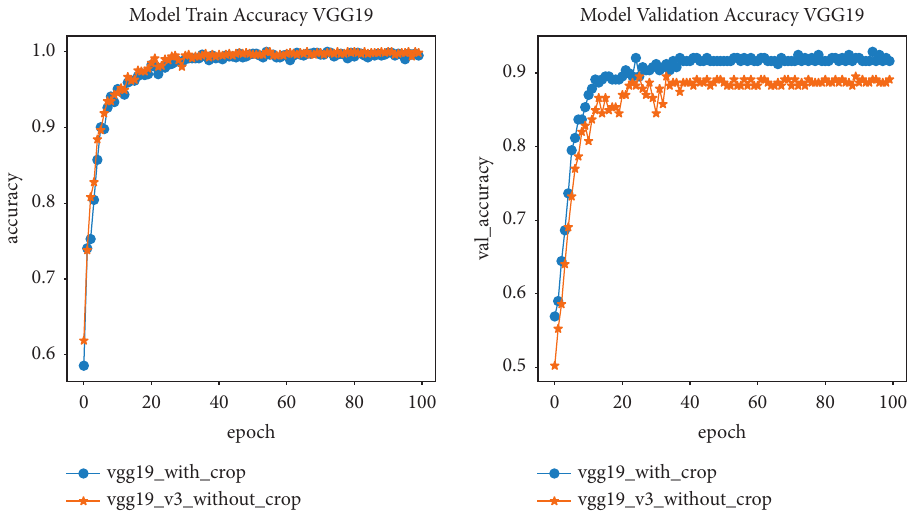
Figure 9: Accuracy of VGG19 network architecture before and after normalization.